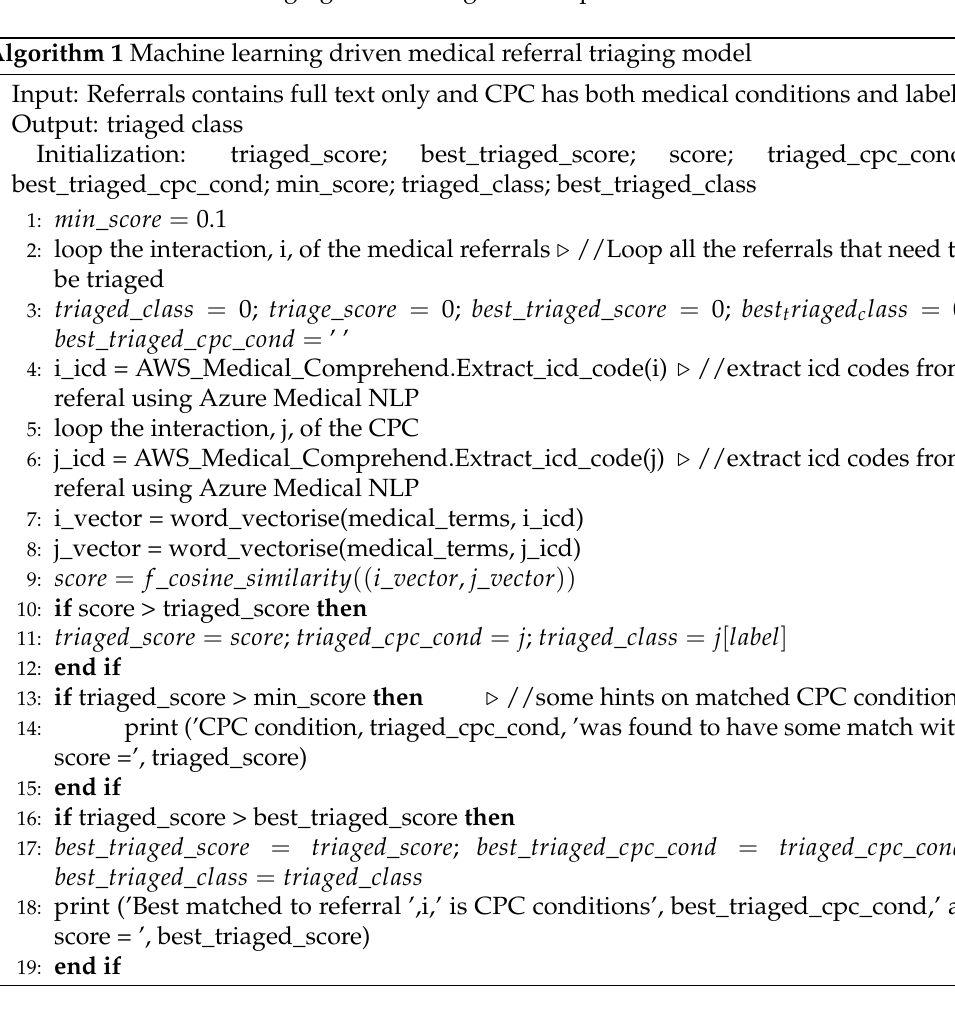
Algorithm 1 Machine learning driven medical referral triaging